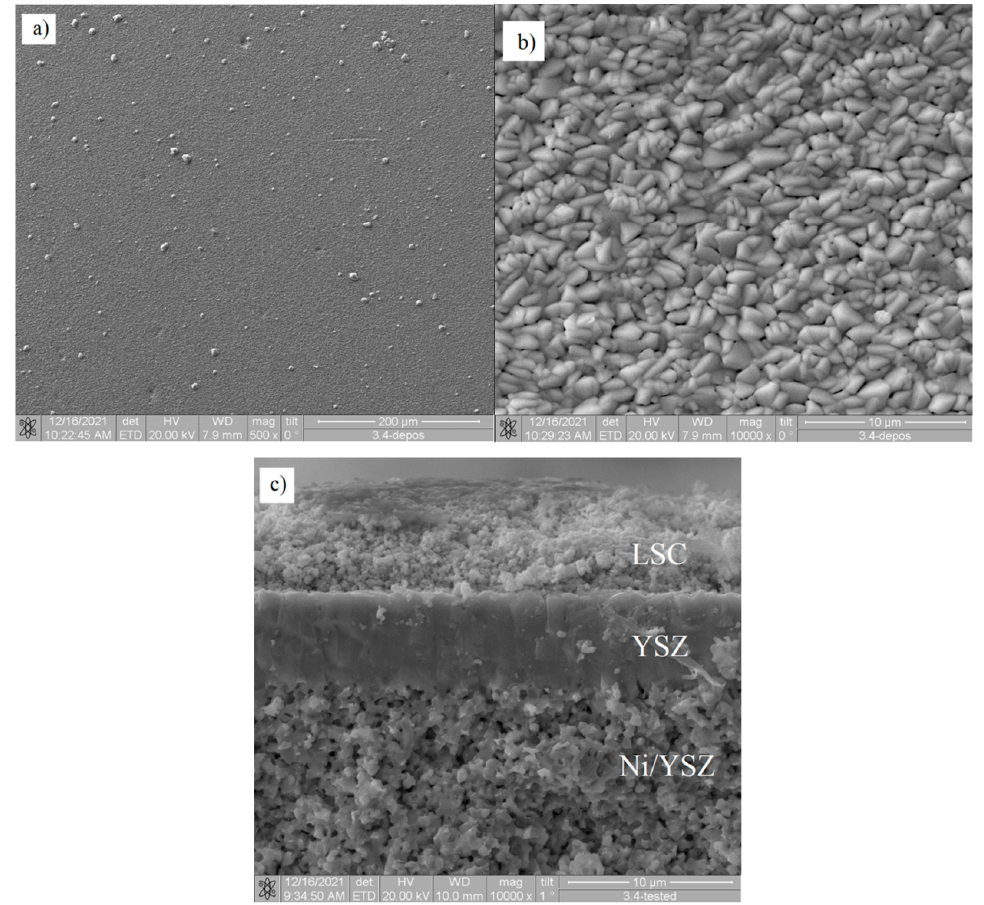
Figure 8. SEM images of YSZ film 5 after 1200 ◦ C dead-load annealing: ( a , b )—surface, ( c )—cross- section.